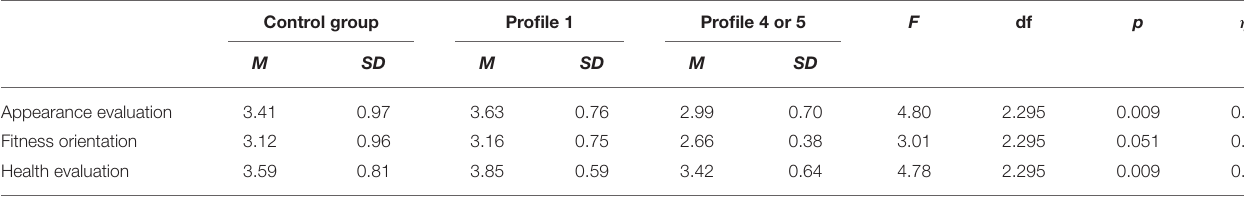
TABLE 7 | Mean values of body image indicators with one-way ANOVA.